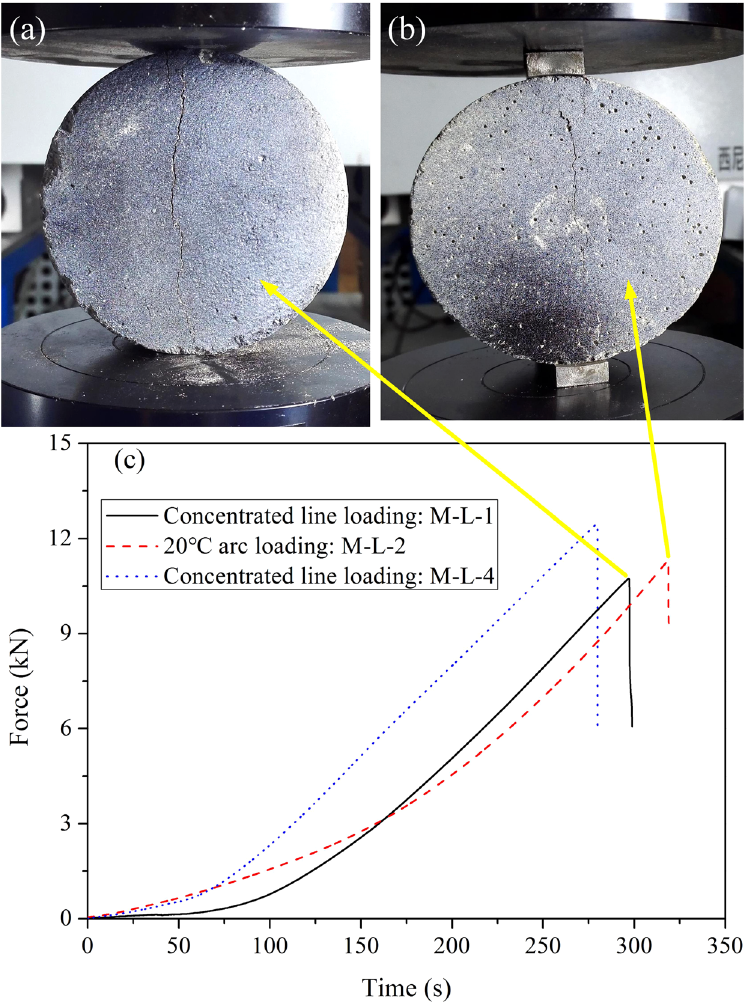
Figure 4. Influence of loading methods: ( a ) the failure mode of M-L-1 with concentrated line loading, and ( b ) the failure mode of M-L-2 with 20° arc loading, and ( c ) their force-time